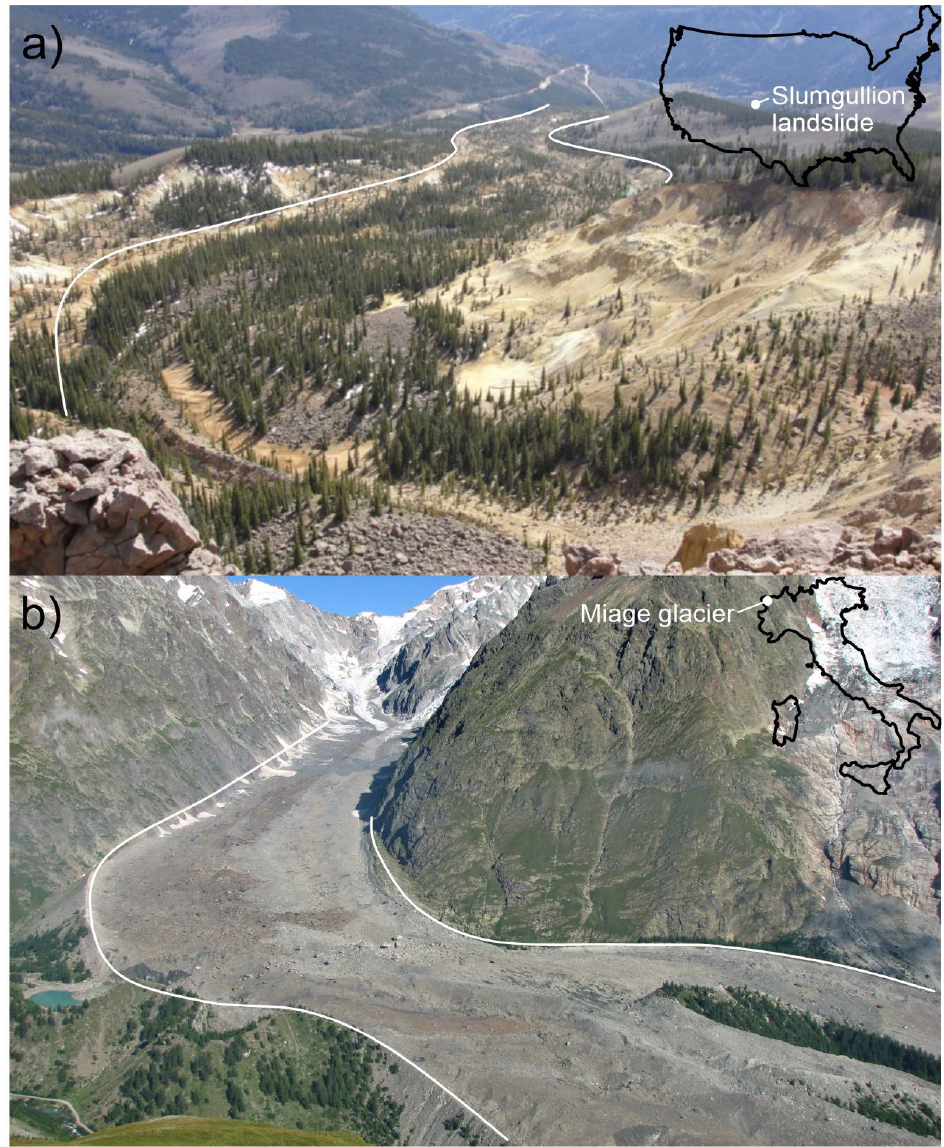
Figure 1. ( a ) Slumgullion landslide as seen from the top of the head looking toward southwest. ( b ) Miage glacier as seen from the opposite flank of the Veny valley. Artworks indicate the approximate boundary of the moving landslide and glacier tongue.